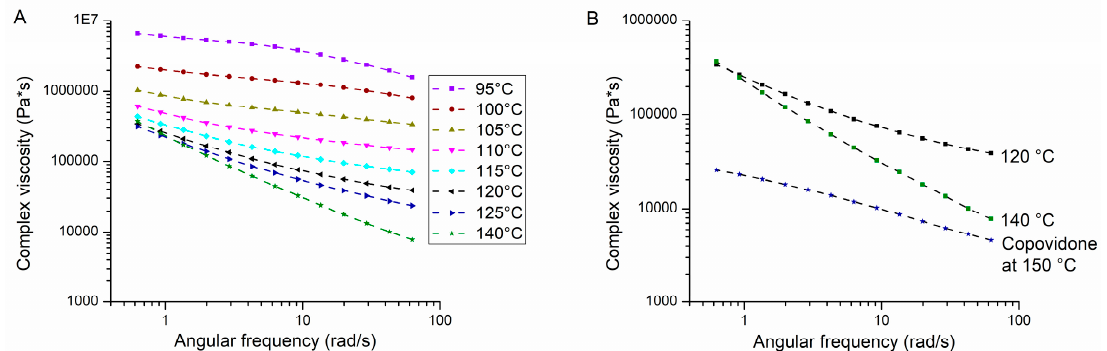
Figure 3. E ff ect of angular frequency on complex viscosity at di ff erent temperatures of the PVAP / PEG Figure 3. Effect of angular frequency on complex viscosity at different temperatures of the 3000 blend ( A ). Comparison of frequency sweeps of the PVAP / PEG 3000 blend at 120 and 140 ◦ C with PVAP/PEG 3000 blend ( A ). Comparison of frequency sweeps of the PVAP/PEG 3000 blend copovidone at 150 ◦ C ( B ). at 120 and 140 °C with copovidone at 150 °C ( B ).